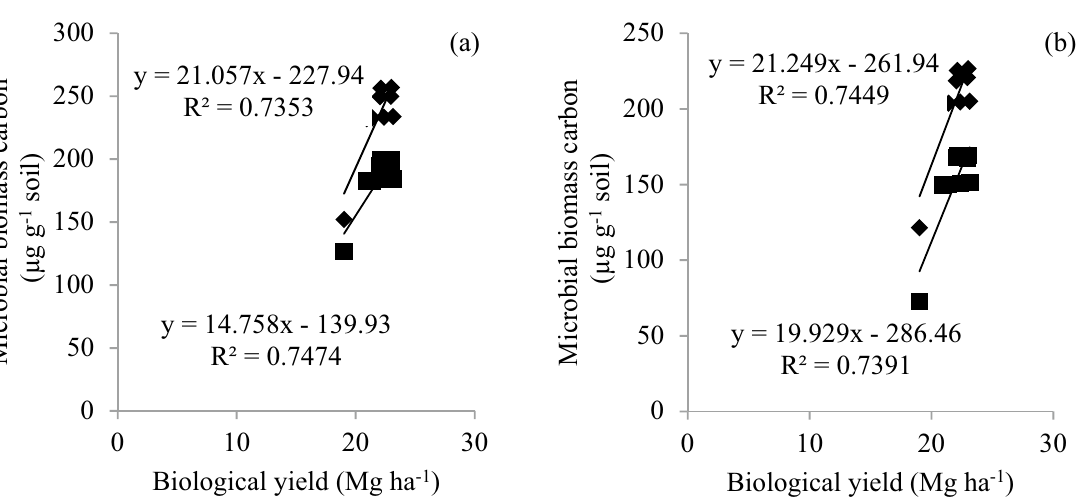
y = 21.057x - 227.94